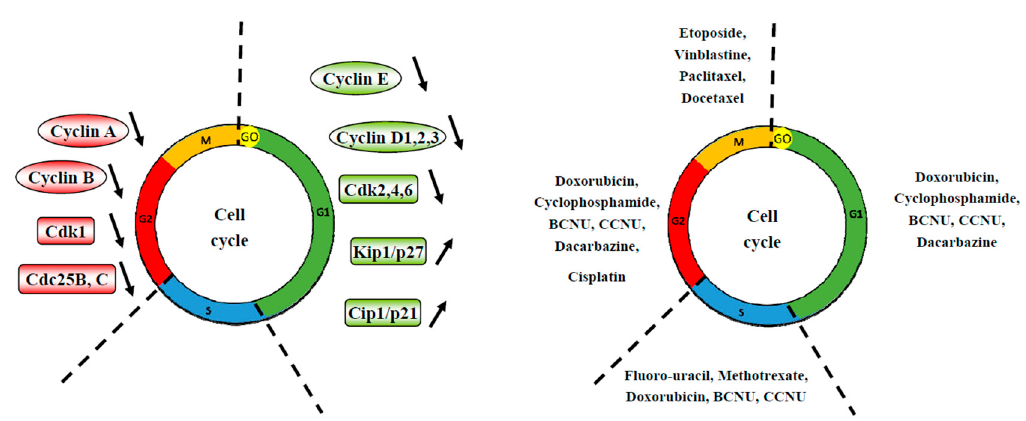
Figure 3. E ff ect of silymarin on key regulators of cell cycle. Cell cycle progression is controlled by key regulators such as cyclin and their kinase, cyclin-dependent kinase (Cdk). Silymarin and its derivative are able to block tumoral cells in the di ff erent phase of the cell cycle through a decrease of cyclins and associated Cdks and to increase the inhibitors proteins that negatively regulate the cell cycle. Furthermore, various antitumoral agents are able to target specific phase of the cell cycle. By this way, silymarin and its derivatives may sensitize cancer cells to these anticancer agents.